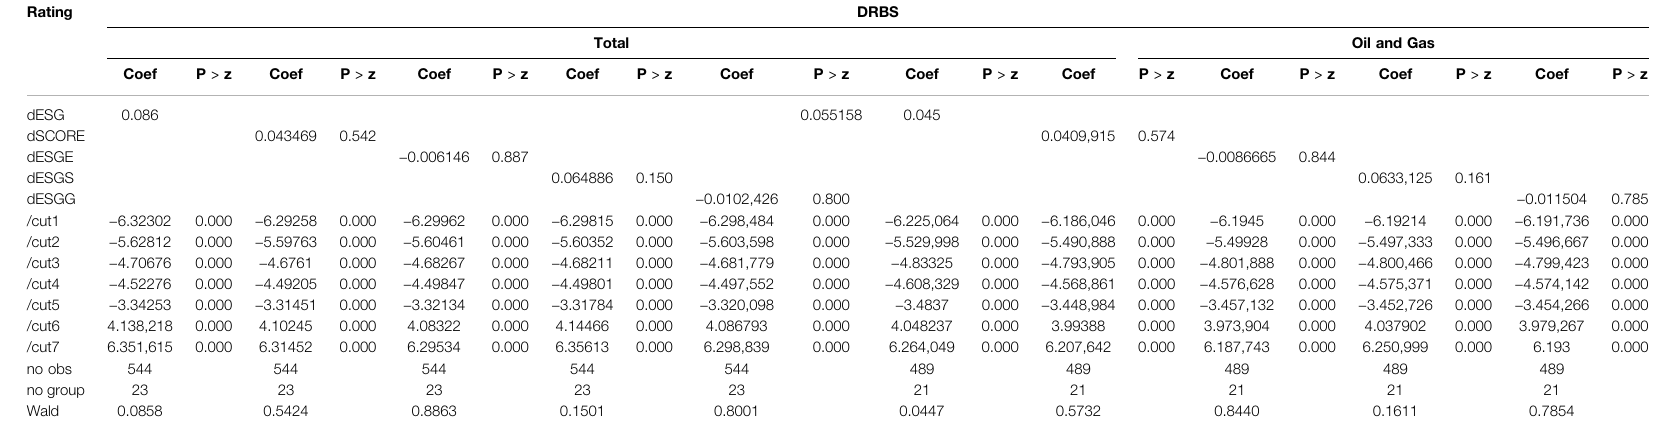
TABLE 8 | Impact of ESG factors on DRBS long-term issuer credit rating changes according to sector division. Rating